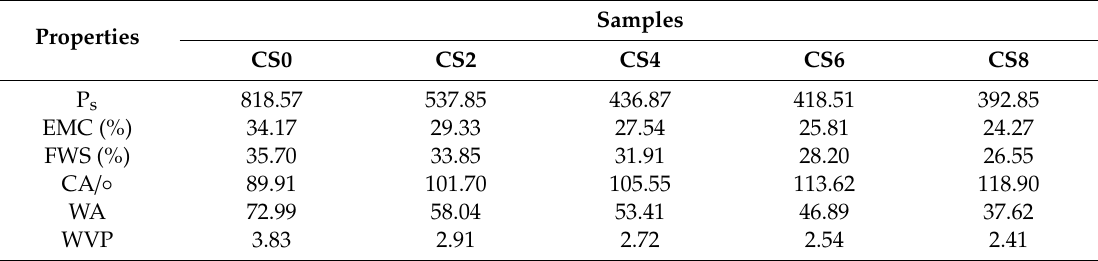
Table 1. Water barrier properties of the